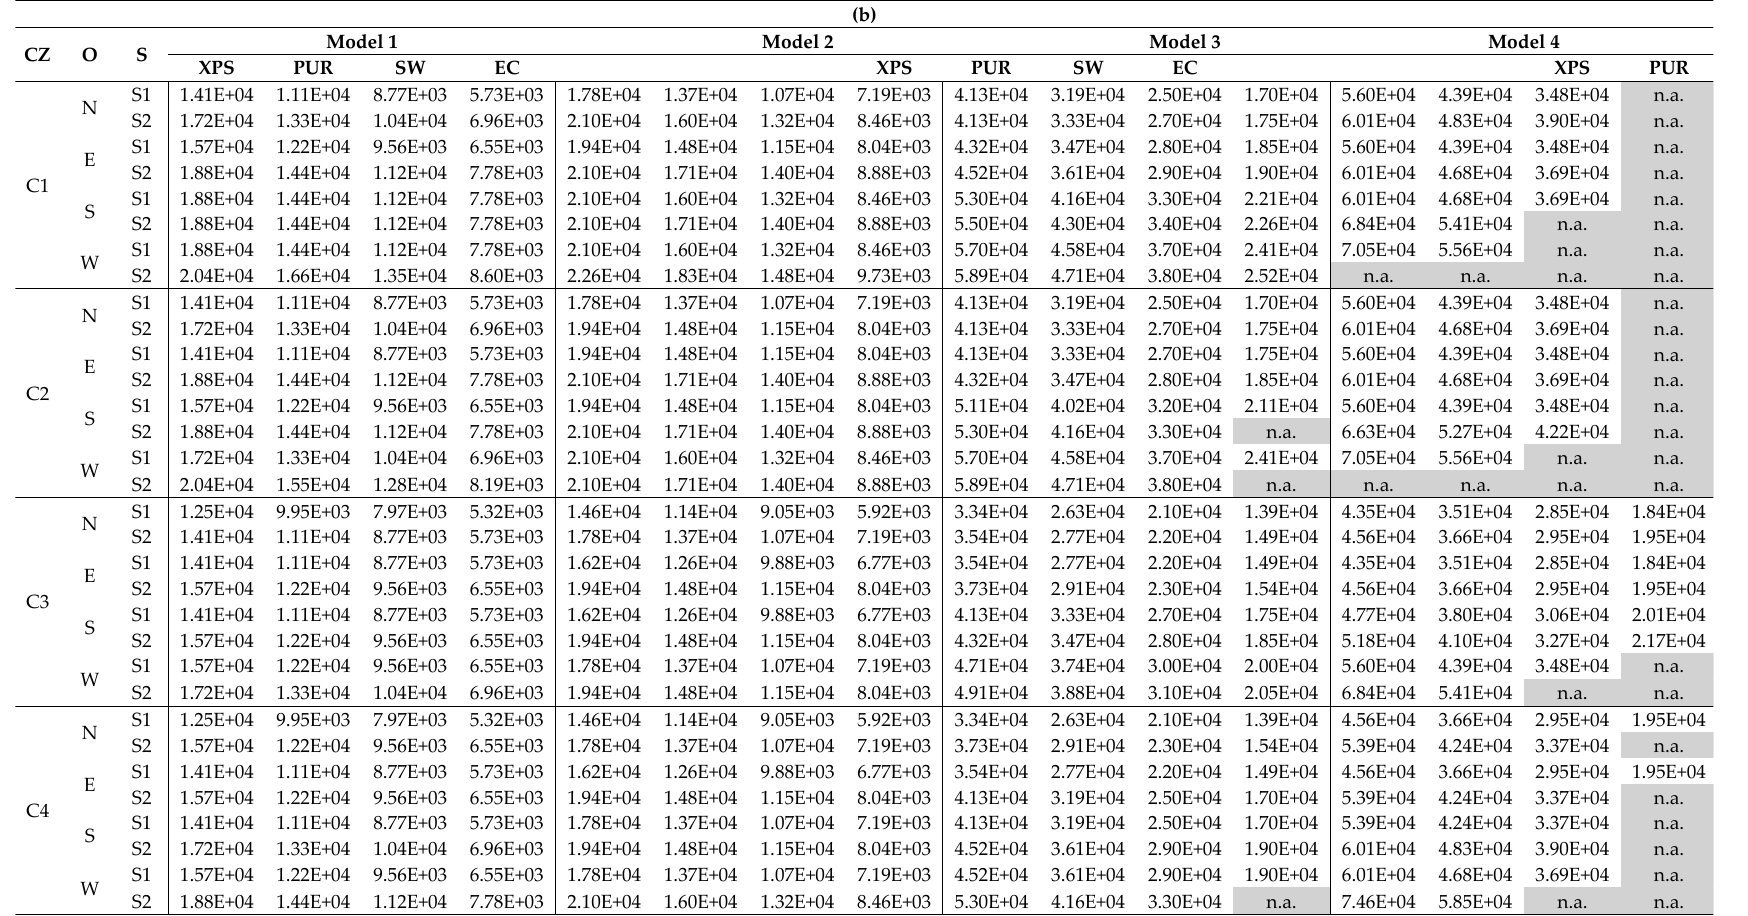
Table A6b. Emissions of CO 2 according to climate zone (CZ), orientation (O), constructive solution (S), building model and insulation material model (in Kg CO 2 ), for